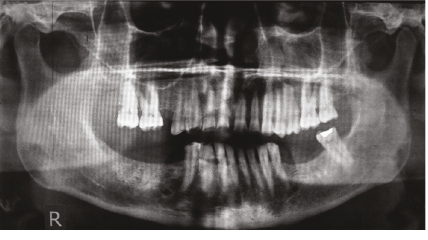
Figure 2: Preoperative